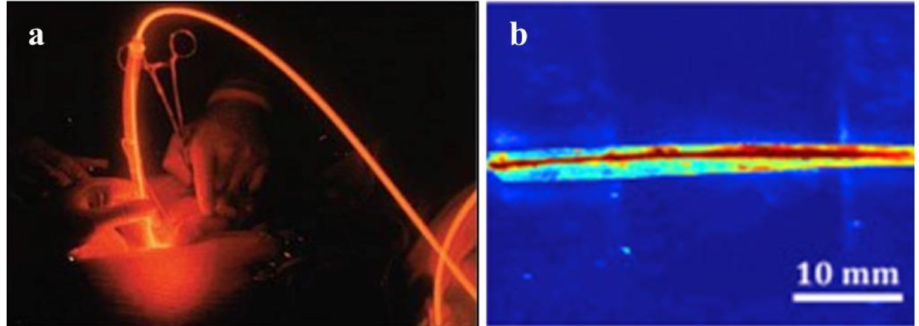
Figure 8. ( a ) An example of photodynamic therapy. (Reprinted with permission from ref. [55]). ( b ) Side view of light delivery using the citrate-based fiber, with the POC cladding and POMC core using a two-step fabrication method. (Reprinted with permission from ref.